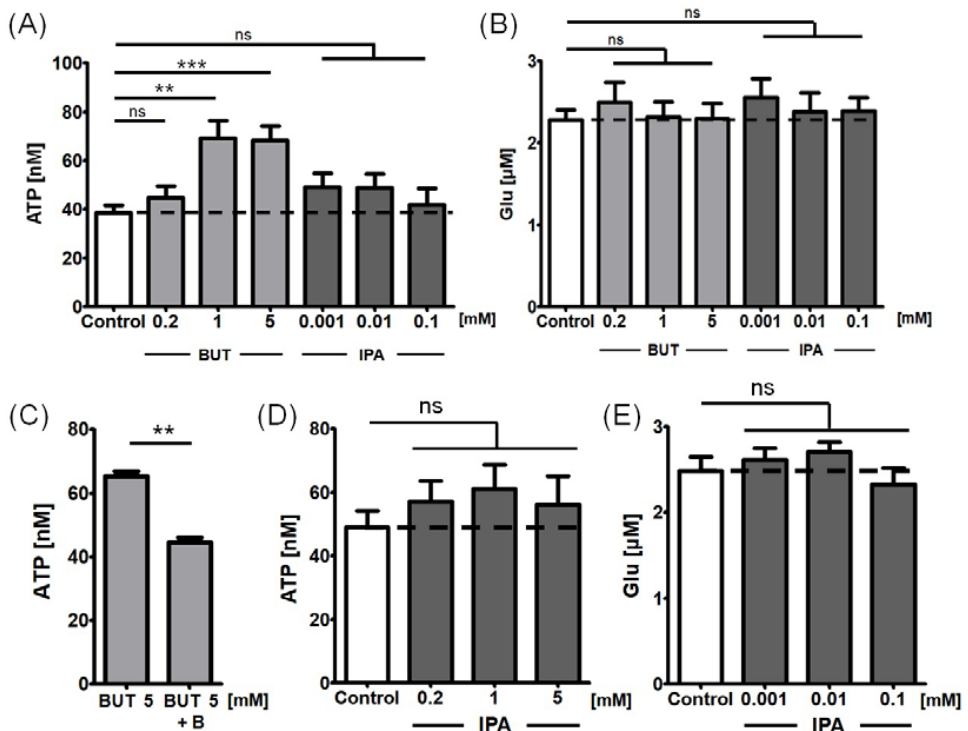
Figure 3. Effects of BUT and IPA on ATP and Glu release from the cultured astrocytes. ( A ) Effect on ATP release following 10-min treatment. ( B ) Effect on Glu release following 10-min treatment. ( C ) Attenuation of the BUT effect on ATP release by 30-min pre-incubation with BAPTA-AM 50 µ M. ( D ) Effect on ATP release following 24-h pre-treatment with IPA. ( E ) Effect on Glu release following 24-h pre-treatment with IPA. The bars represent the mean estimates, whereas the whiskers indicate standard errors of means. Dashed lines indicate the levels of ATP and Glu release in control conditions (fresh experimental medium or HEPES buffered Ca 2+ -containing solution, respectively). Number of biological replicates n ≥ 9 for each condition. One -way analysis of variance with post hoc Dunnet t’s test, significance level α = 0.05. ** p < 0.01, *** p < 0.001. ns—not significant, B—BAPTA-AM.